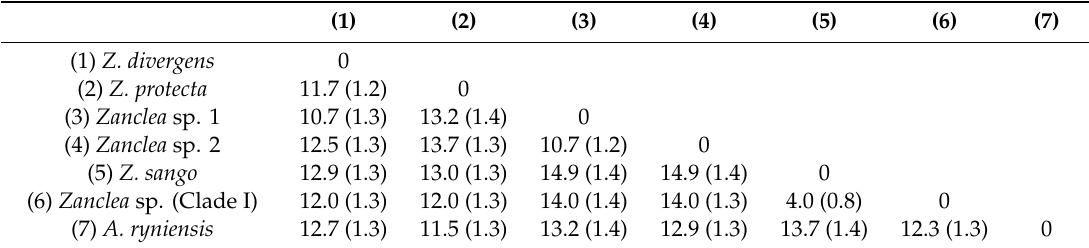
Table 4. Pairwise % uncorrected p -distances ( 16S rRNA ) between all species